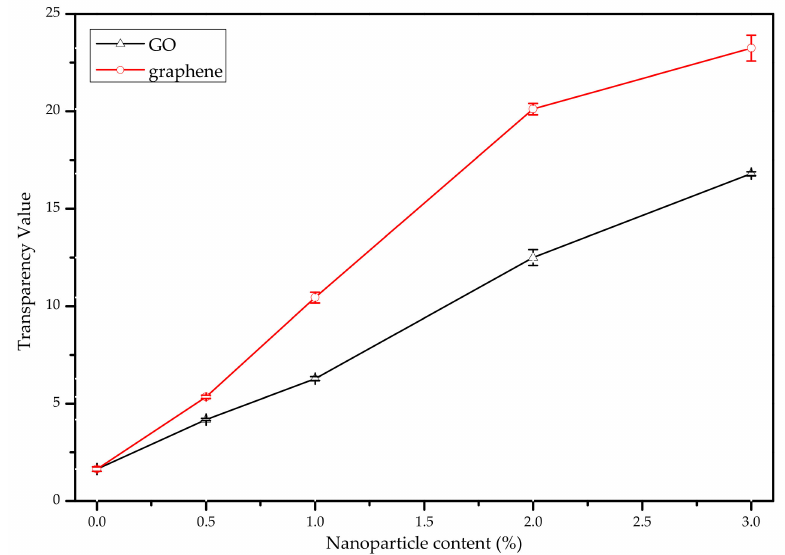
Figure 7. Transparency value (T) of the P-40-25 film modified with varying levels of GO and graphene